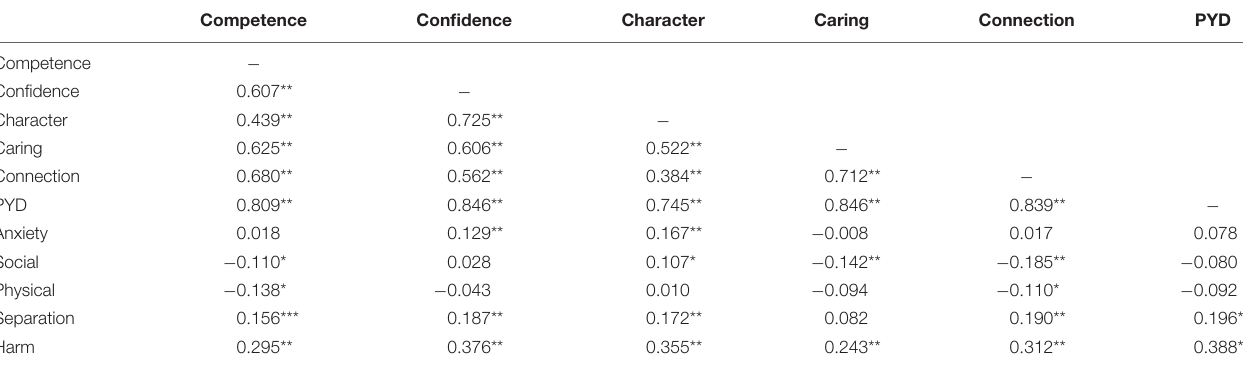
TABLE 1 | Correlations between the 5Cs and anxiety dimensions in the Portuguese